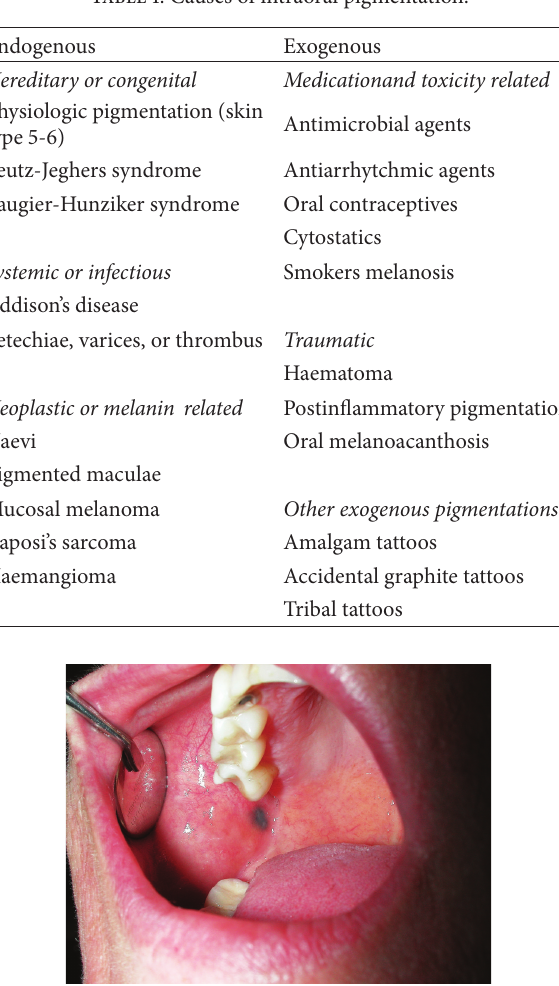
Figure 1: Clinical photograph of the 3 × 5 mm pigmented lesion of the left buccal mucosa mimicking mucosal melanoma.